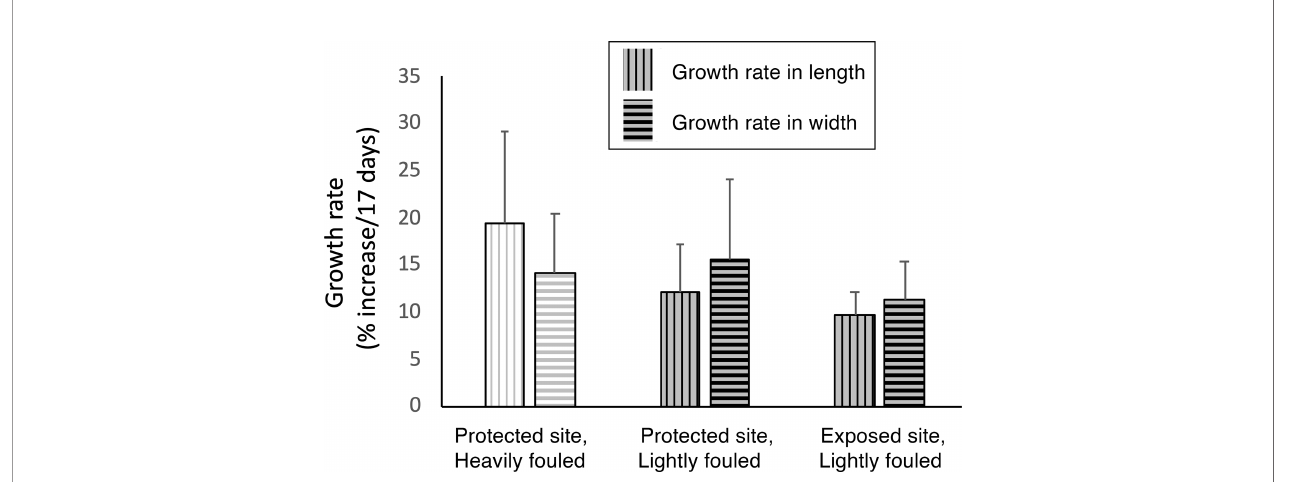
FIGURE 6 | Effect of fouling by M. membranacea on linear growth (% increase per 17 days) of M. splendens in length (vertical hatch marks) and width (horizontal hatch marks). Bars with white backgrounds indicate algae heavily fouled with bryozoans, and bars with grey backgrounds indicate lightly fouled algae. Neither fl ow habitat nor degree of fouling had a signi fi cant effect on algal growth rates in length (p > 0.05, one-way ANOVA followed by Tukey HSD test, F = 3.05 2,13 ) or in width (p > 0.05, one-way ANOVA followed by Tukey HSD test, F = 1.14 2,13 ).